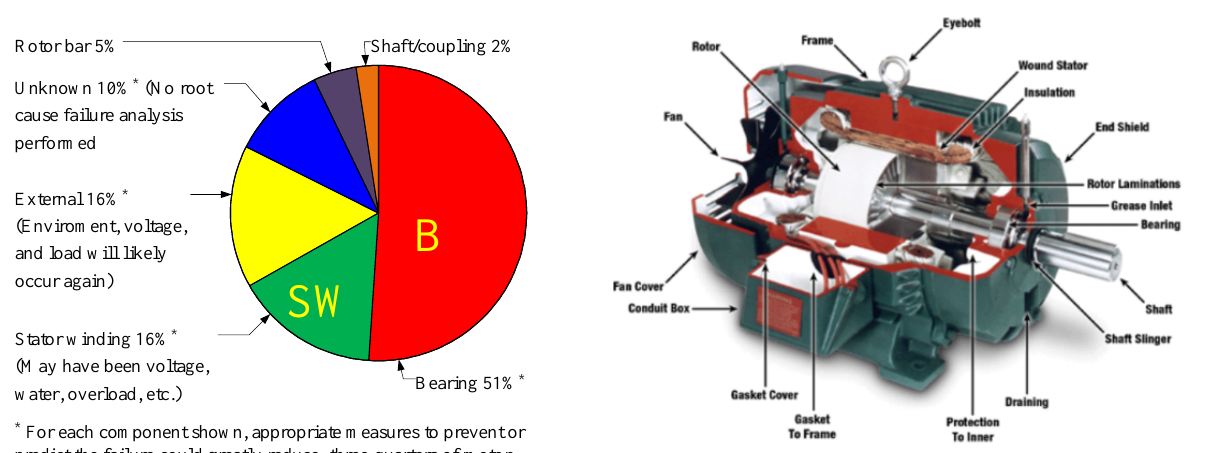
Figure 2: Failure mode distribution for induction ma- chine.